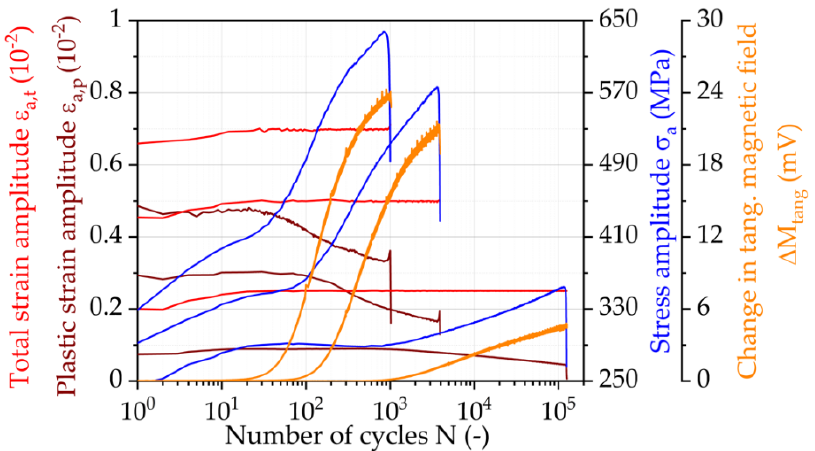
Figure 3. Change in tangential magnetic field ∆ M tang results of three CATs at RT with ε a , t = 0.25%, 0.50% and 0.70%.